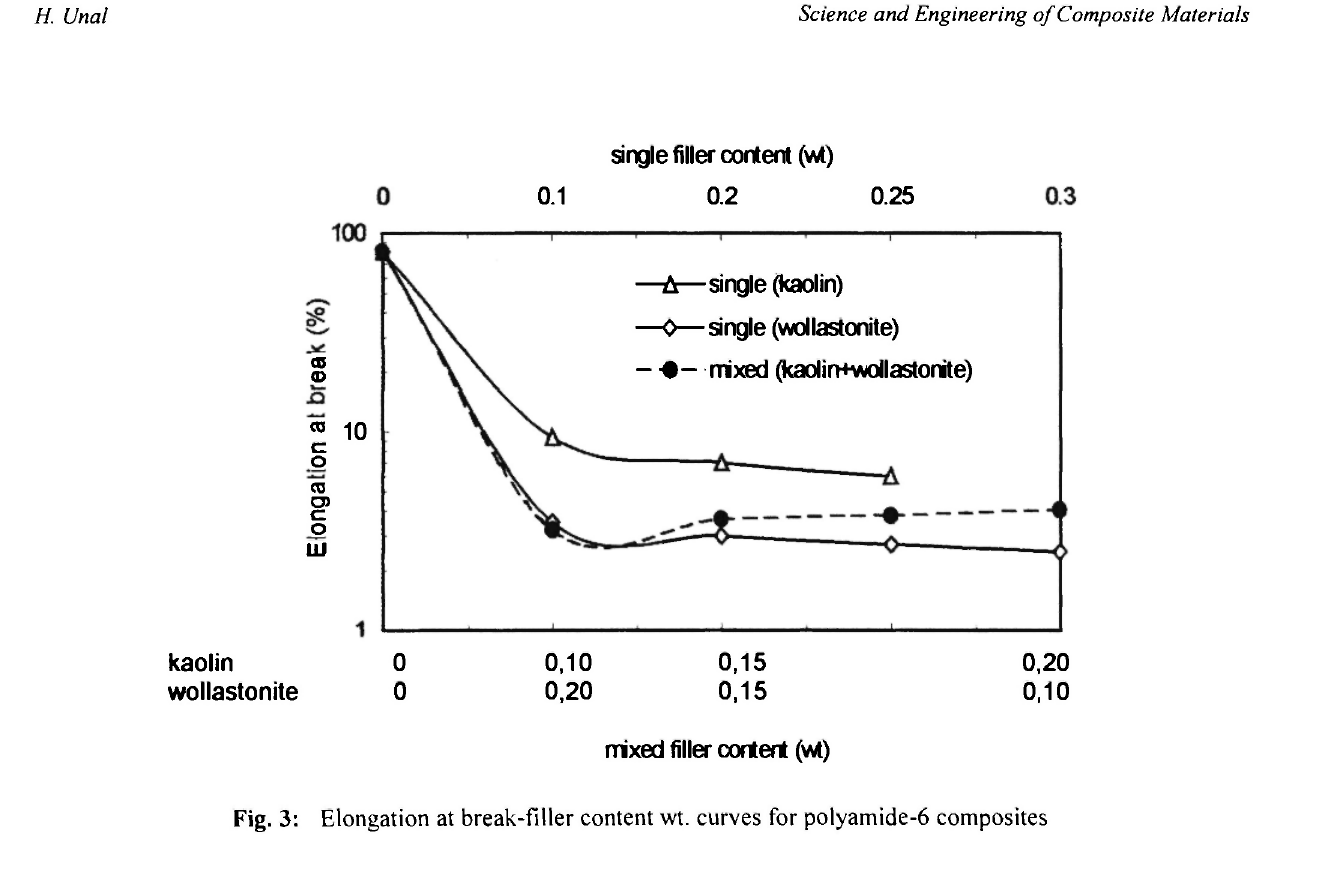
Fig. 3: Elongation at break-filler content wt. curves for polyamide -6 composites